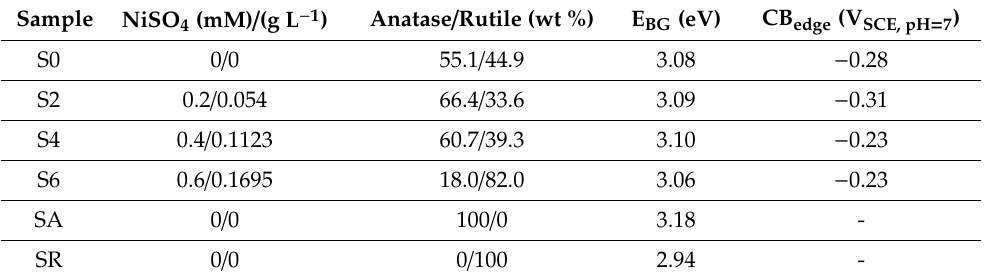
Table 1. Sample labelling, corresponding NiSO 4 concentration in the electrolyte, anatase / rutile weight fraction, band-gap energy (E BG ), conduction band edge (CB edge